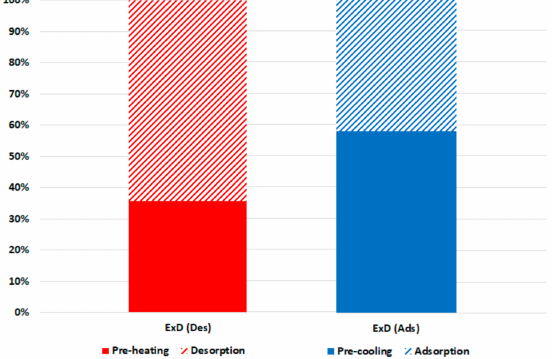
Figure 8. Exergy destruction in the adsorbent beds at 30 ◦ C recooling-water temperature.